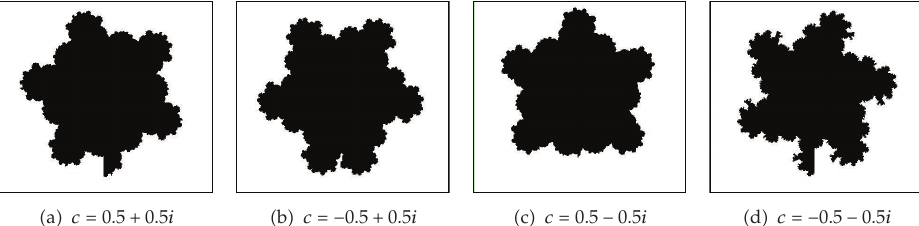
(cid:3) a (cid:4) c (cid:6) 0 . 5 (cid:5) 0 . 5 i Figure 6: The generalized J sets without any perturbation when α (cid:6) 5 . 5, θ ∈ (cid:7) − 3 π/ 2 ,π/ 2 (cid:4) .